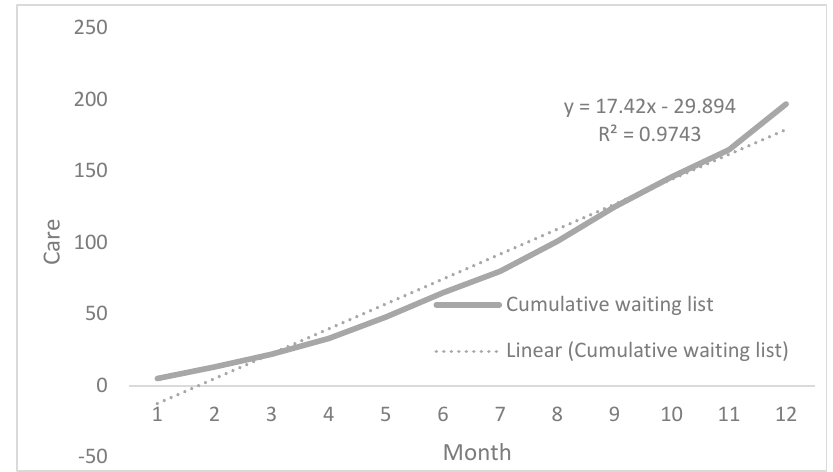
Figure 5. Monthly growth of the waiting list.